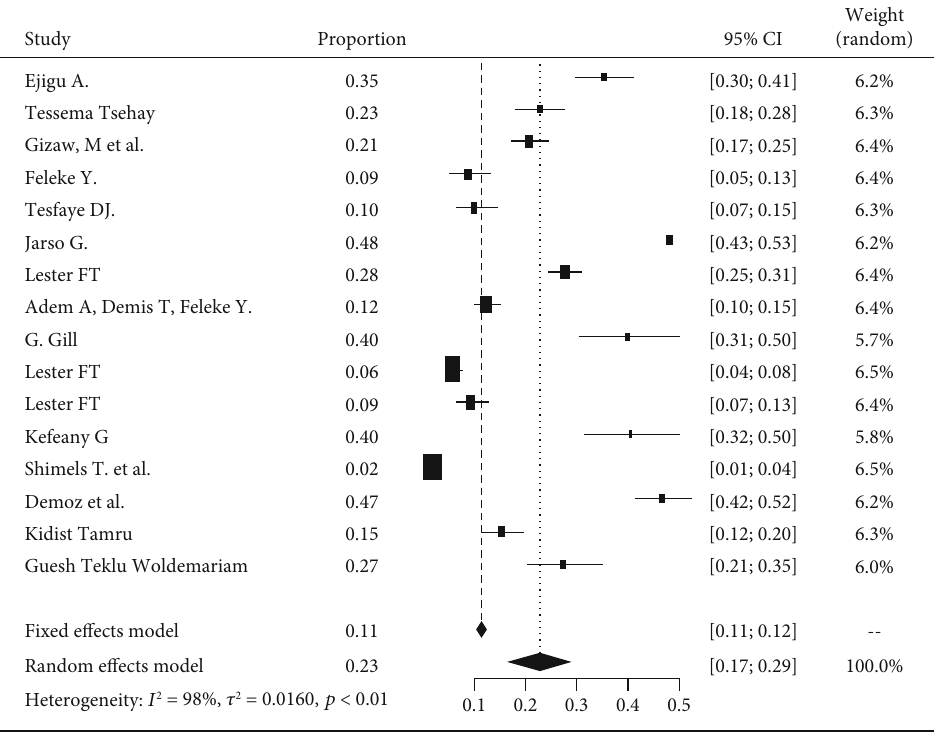
Figure 4: Forest plot of DPN in Addis